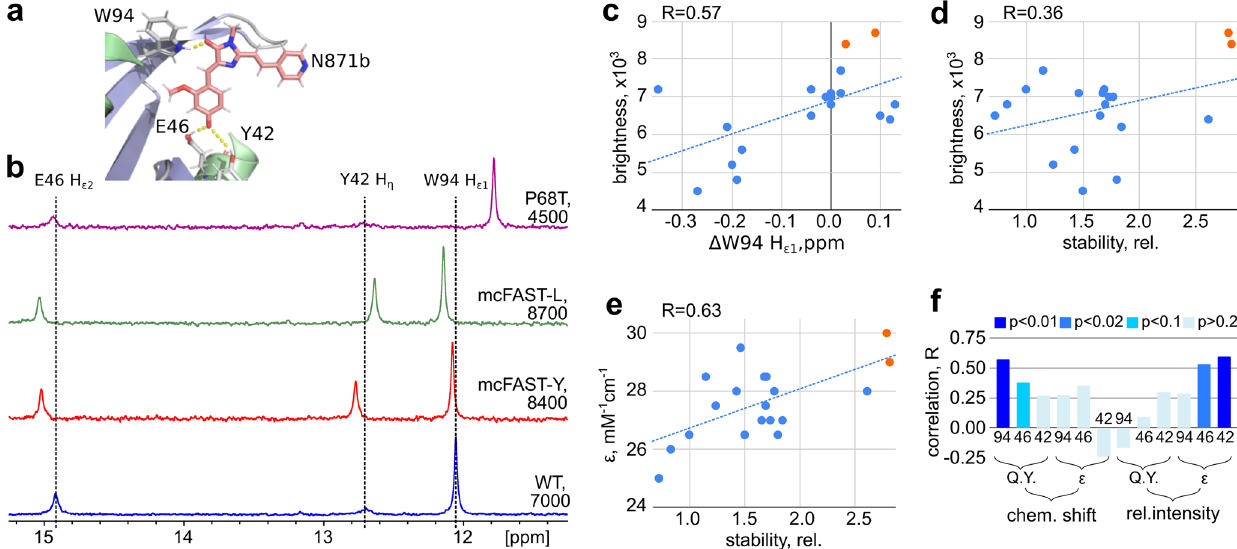
Fig. 4 NMR analysis of FAST/N871b complexes. a Ligand/protein intermolecular hydrogen bonds are shown on the structure of FAST/N871b complex. b Overlay of 1 H NMR spectra of FAST/ N871b complexes, recorded for the wild-type protein and its three mutants: mcFAST-Y, mcFAST-L (the best mutants) and P68T (the worst mutant). Spectra were obtained at 25 o C, molecular brightness of the complex is indicated. c Correlation between the chemical shift of H ε 1 W94 and brightness of FAST/ N871b complex. d , e correlations between the FAST/ N871b brightness and NMR-derived stability of three intermolecular H-bonds ( d ) or molar extinction coef fi cient ( ε , e ). mcFAST-Y and mcFAST-L mutants are highlighted in orange. f Pearson correlation coef fi cients, obtained for the chemical shifts and relative intensities of signals, corresponding to intermolecular H-bond protons of FAST/ N871b complexes, and either quantum yield (Q.Y.) or molar extinction coef fi cient. Bars are colored according to the statistical signi fi cance of the correlation.